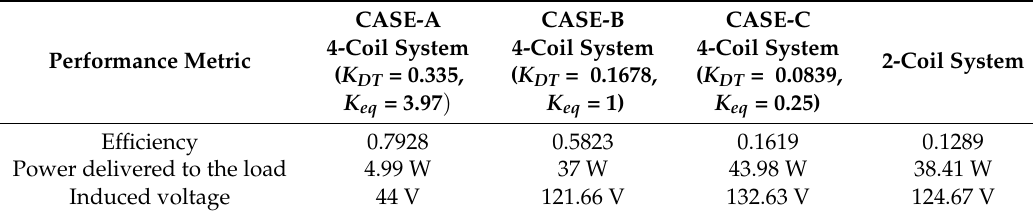
Table 2. Performance of the WPT systems.